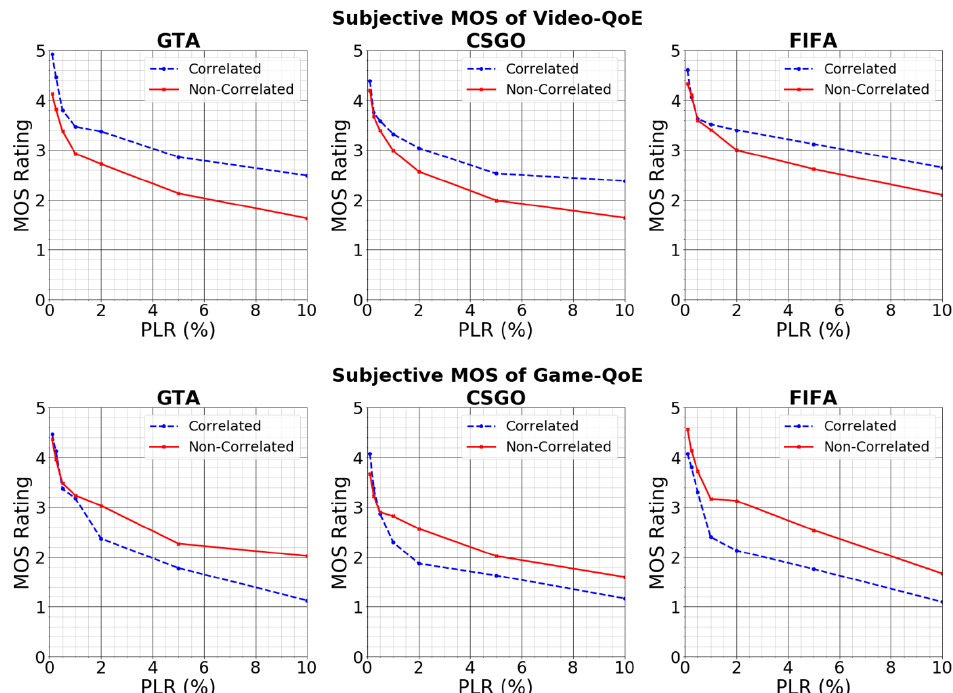
Figure 6. Subjective QoE